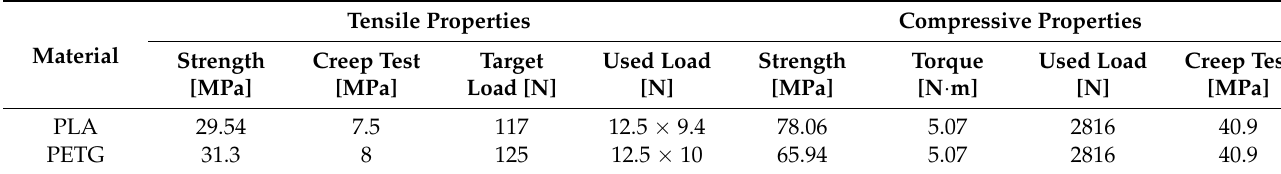
Table 4. Loads used for creep testing.